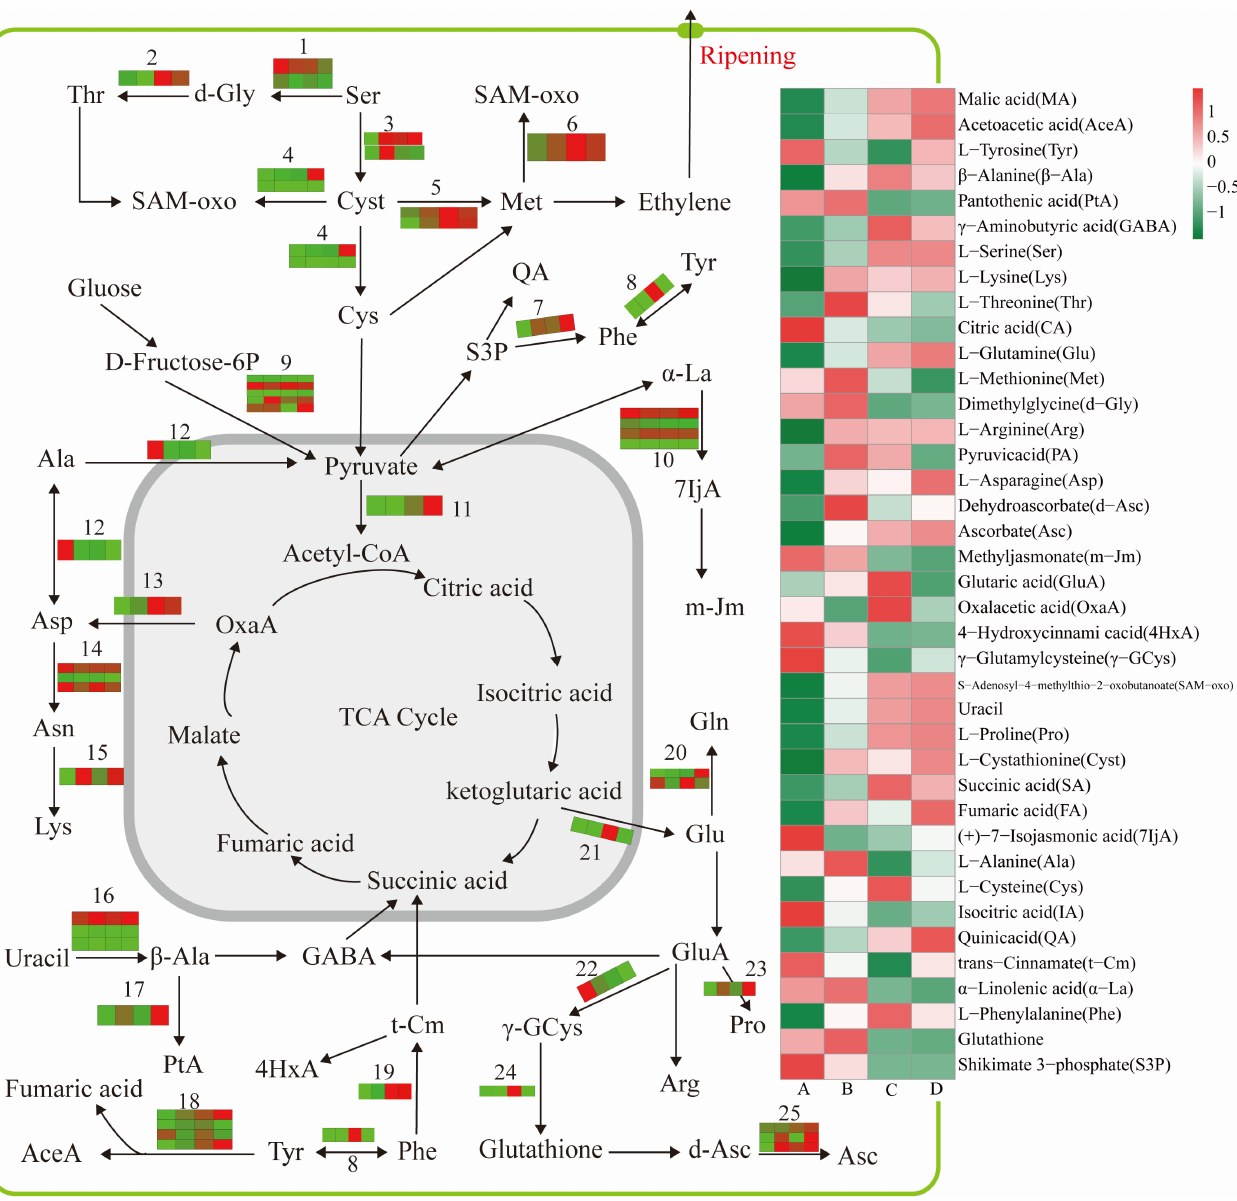
Figure 5. Pathway displays a subset of organic acid and amino acid metabolism proteases re- quired in coffee cherries. The metabolites changing as ripening progresses from A to D are presented in four box strings. Heat maps, for each numbered reaction, were drawn using the TMT value. The numbered reactions were catalyzed by the following enzymes: 1, serine hydrox- ymethyltransferase (A0A6P6TLR0) and glutamate-glyoxylate aminotransferase 2 (A0A6P6VAJ1); 2, L-threonine aldolase 1 (A0A6P6VRS3); 3, homoserine kinase (A0A6P6VCB8) and cysteine synthase (A0A6P6WQV5); 4, L-cysteine desulfhydrase (A0A6P6VZM9) and farnesylcysteine lyase (A0A6P6T9Z7); 5, 5-methyltetrahydropteroyl triglutamate homocysteine S-methyltransferase (A0A6P6SM43); 6, S-adenosylmethionine synthase (A0A6P6SUD6); 7, shikimate dehydrogenase (A0A6P6X2E2); 8, arogenate dehydratase (A0A6P6W2X6); 9, NADP-dependent glyceraldehyde-3- phosphate dehydrogenase (A0A6P6SZ76), pyruvate phosphate dikinase (A0A6P6WRX8), phospho- glycerate mutase (A0A6P6SCM7), phosphopyruvate hydratase (A0A6P6T3Q6), and glyceraldehyde-3- phosphate dehydrogenase (A0A6P6VC84); 10, allene oxide synthase (A0A6P6UTE2), allene oxide syn- thase 1 (A0A6P6UPD2), allene-oxide cyclase (A0A6P6TAJ2), enoyl-CoA hydratase 2 (A0A6P6TYF9); 11, acetyl-CoA acetyltransferase (A0A6P6SED1); 12, alanine-glyoxylate transaminase